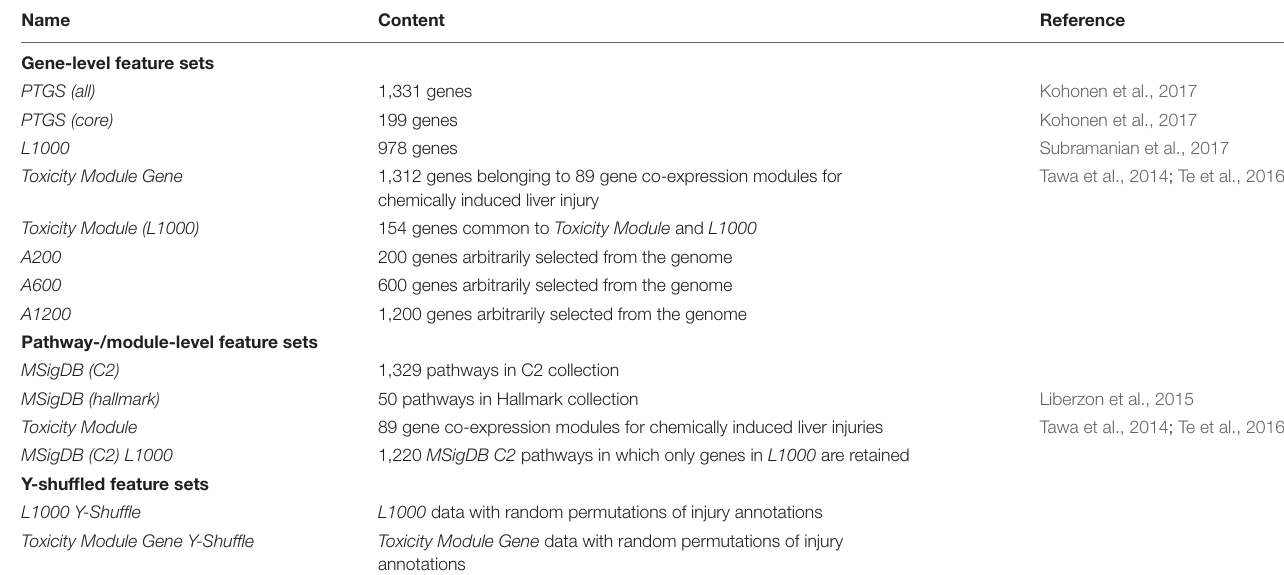
TABLE 2 | Summary of feature sets used in this